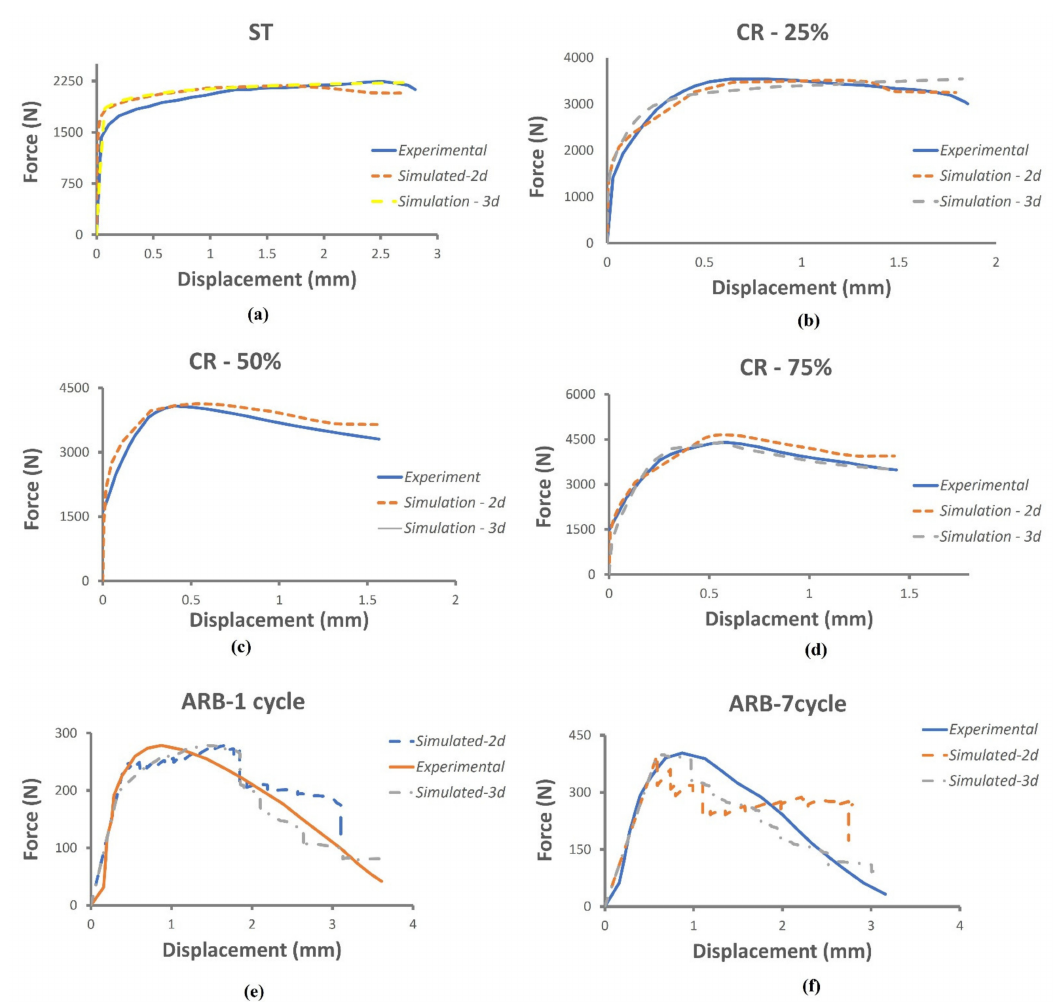
Figure 11. Von Mises stress distribution at ( a ) loading ( b ) crack initiation ( c ), ( d ) crack propagation.